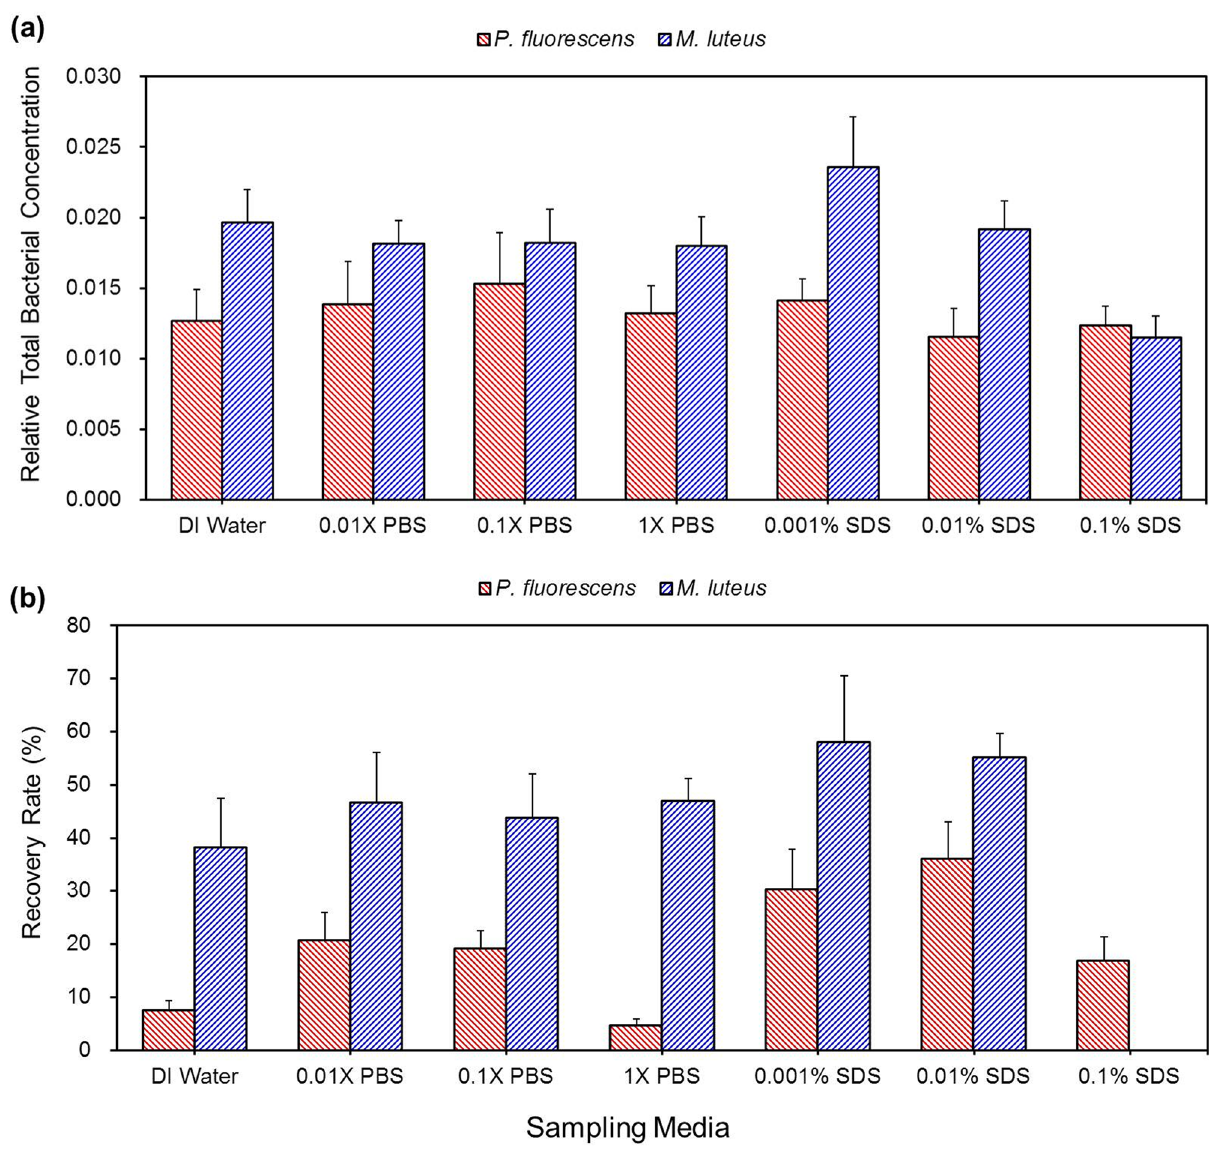
Figure 4. Relative total bacterial concentrations ( a ) and recovery rates ( b ) of P. fluorescens and M. luteus in the EPC (− 5 kV) for deionized (DI) water, phosphate buffered saline (PBS) and sodium dodecyl sulfate (SDS) diluted with DI